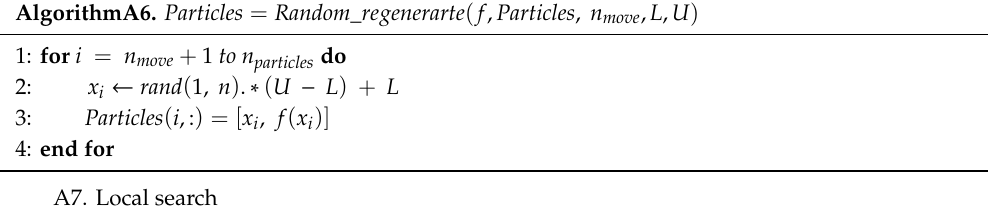
(cid:16) f , Particles , n branch , n leaf , dim , L , U